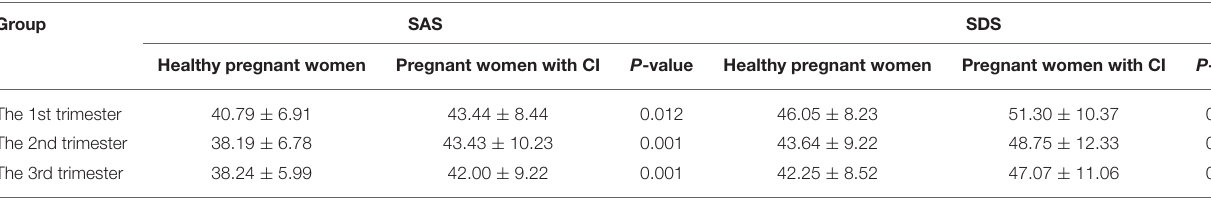
TABLE 3 | Incident rate of anxiety and depression between two groups. Group